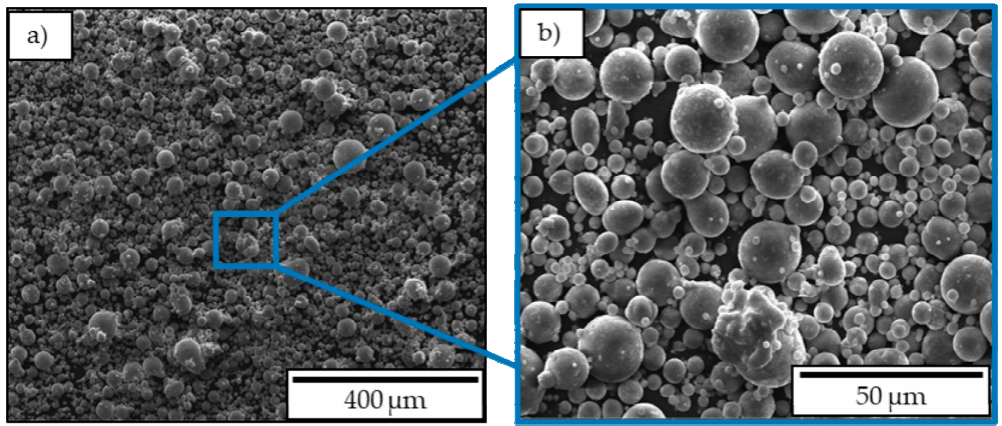
Figure 1. SEM images of a WE43 magnesium powder: ( a ) x500, ( b ) x1,000